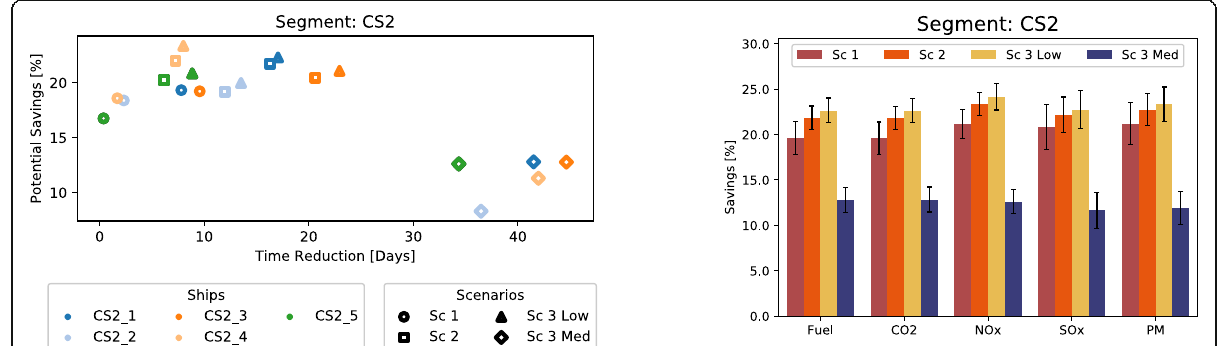
Fig. 9 Results for CS2 ships. (left) STM could reduce or eliminate the large anchoring times, high cruising speed dispersion or excessive idle time at berth. This, combined with low speeds can lead to more than a 20% of reduction in fuel and GHG emissions (right). Even with higher speeds, reduction above a 10% and of more than 30 days of navigation time are possible